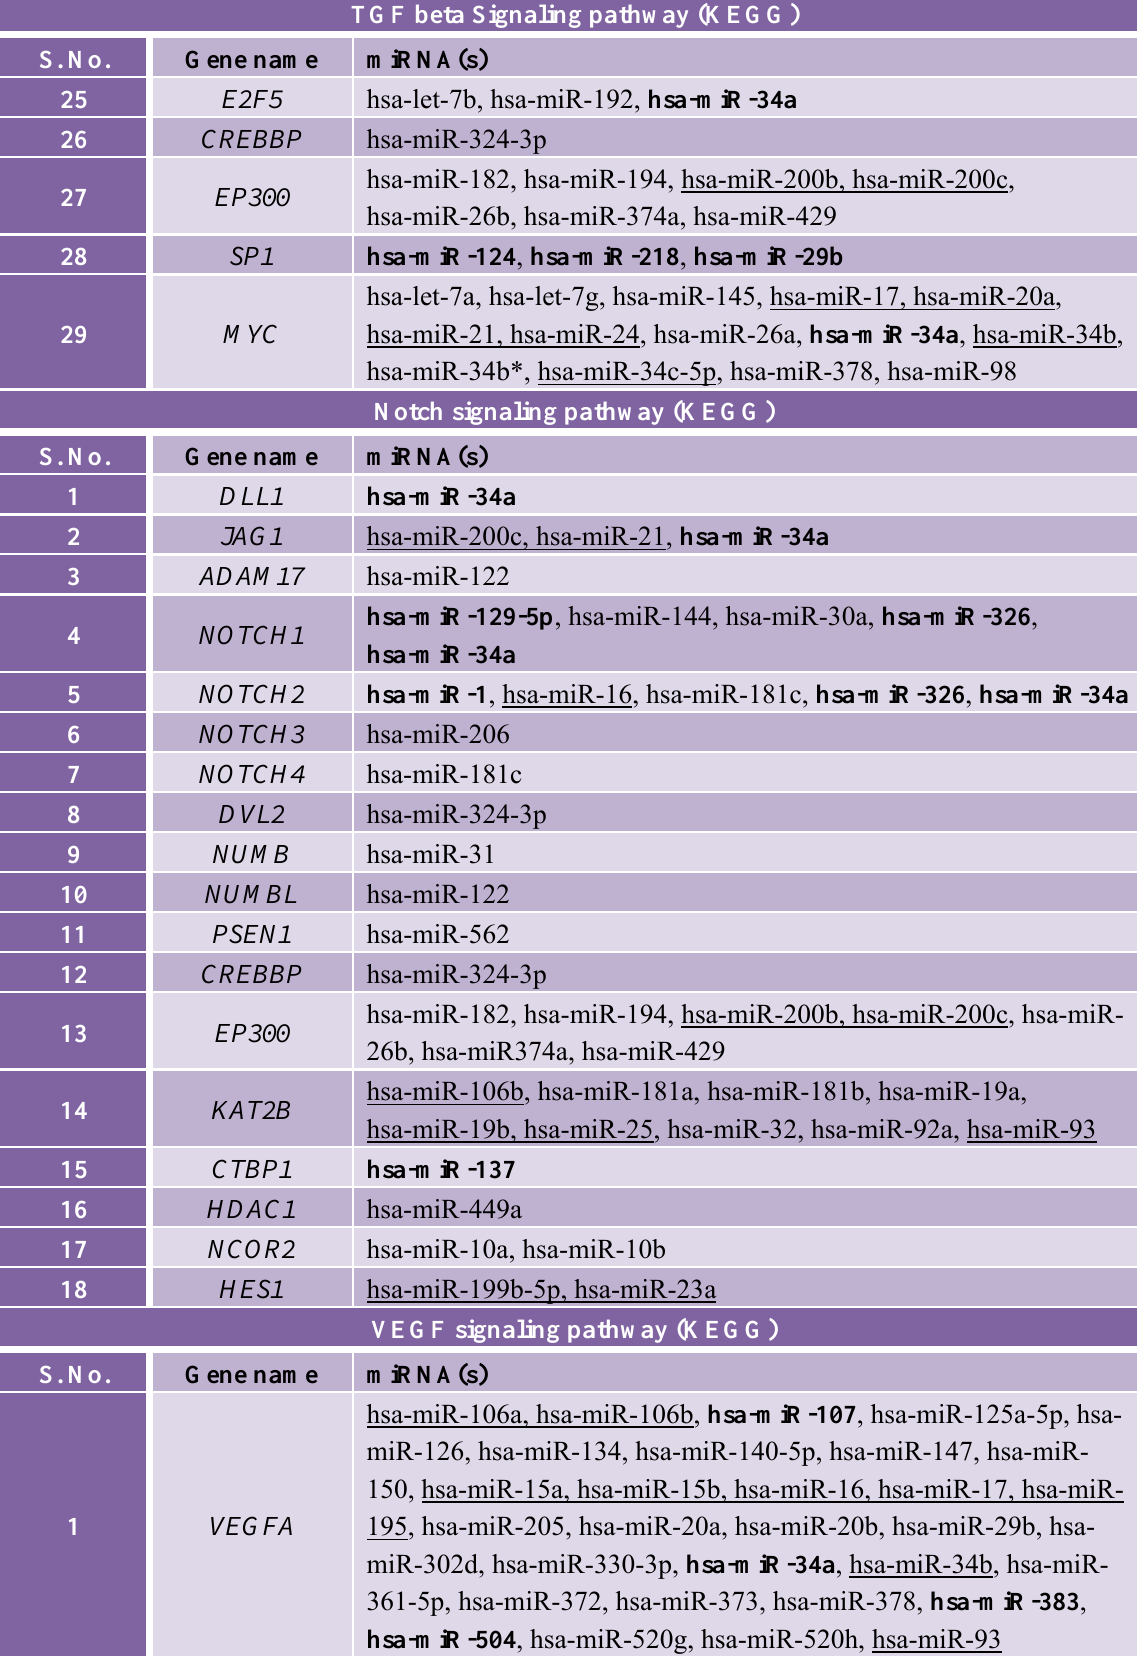
Table 2. Cont . TGF beta Signaling pathway